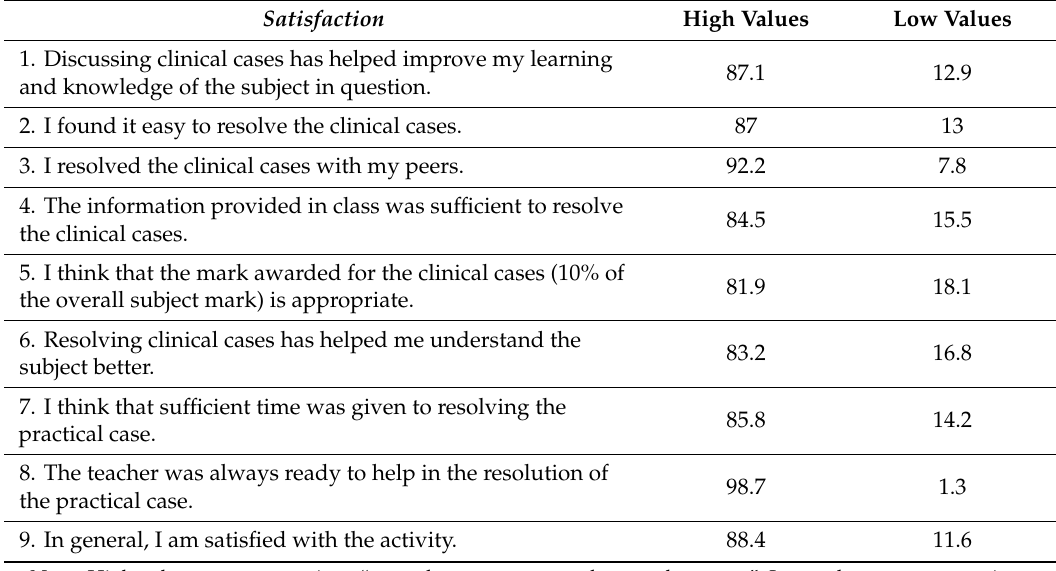
Table 4. Results for items in the Satisfaction Questionnaire concerning the educational innovation